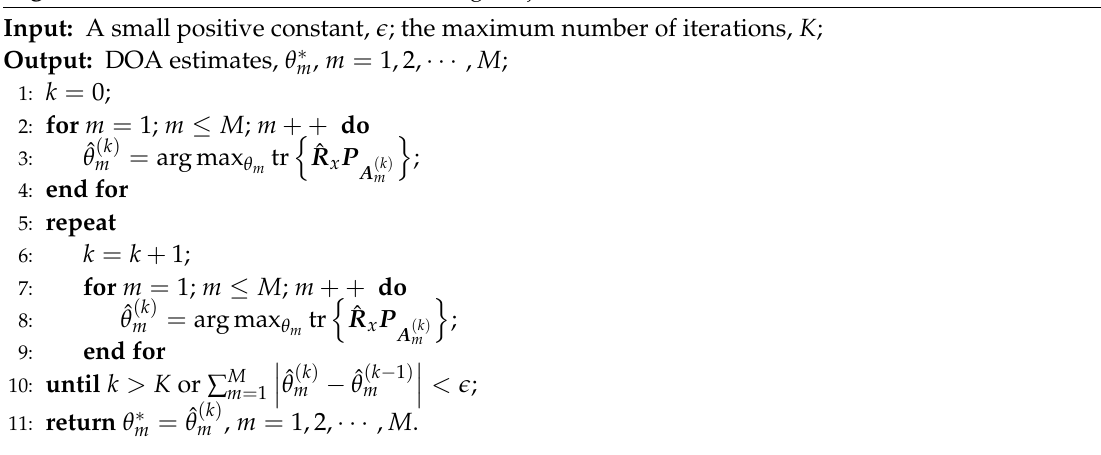
Algorithm 2 The Framework of Alternating Projection Based on ML